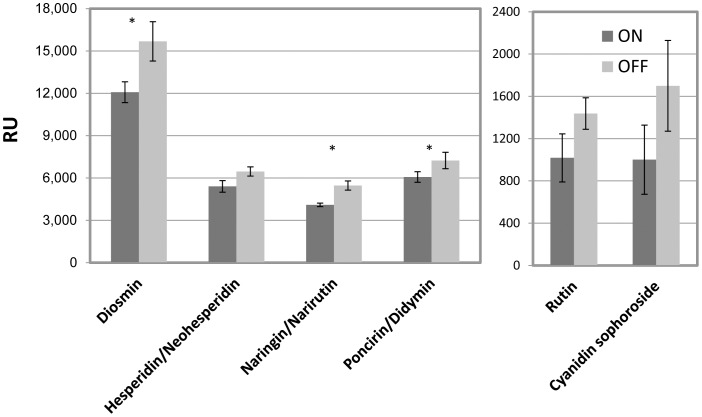
Flavonoid content in ON and OFF buds.The indicated flavonoids were measured in ON and OFF buds using LC-MS. Y axis indicates the intensity of each compound, RU relative units. Mean number of three biological replicates ± SE. Stars denote a significant difference between ON and OFF buds (P<0.05).